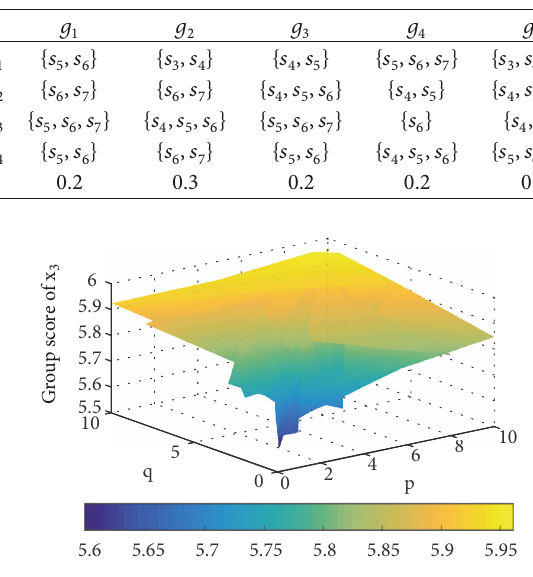
Figure 4: Group scores of the 𝑥 3 .